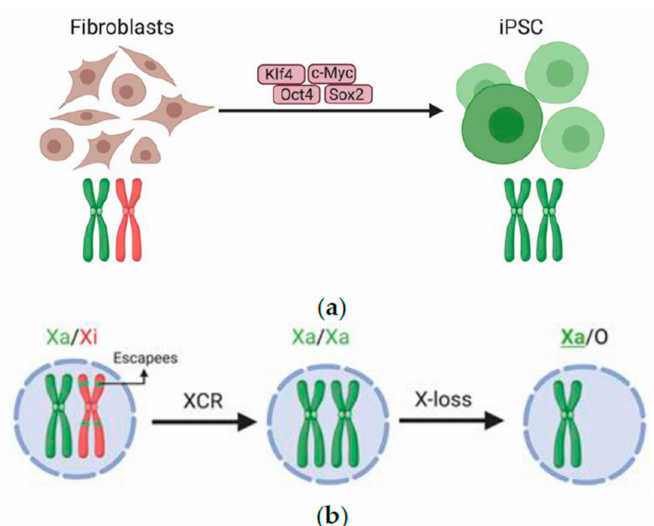
Figure2. X-chromosomereactivation(XCR)duringinducedpluripotentstemcell(iPSC)reprogramming followed by X chromosome aneuploidy. ( a ) Roadmap showing XCR during mouse embryonic fibroblast reprogramming to iPSC by Oct4, Sox2, Klf4 and c-Myc factors; ( b ) XCR followed by rapid loss of X chromosome or X chromosome aneuploidy in XaXa